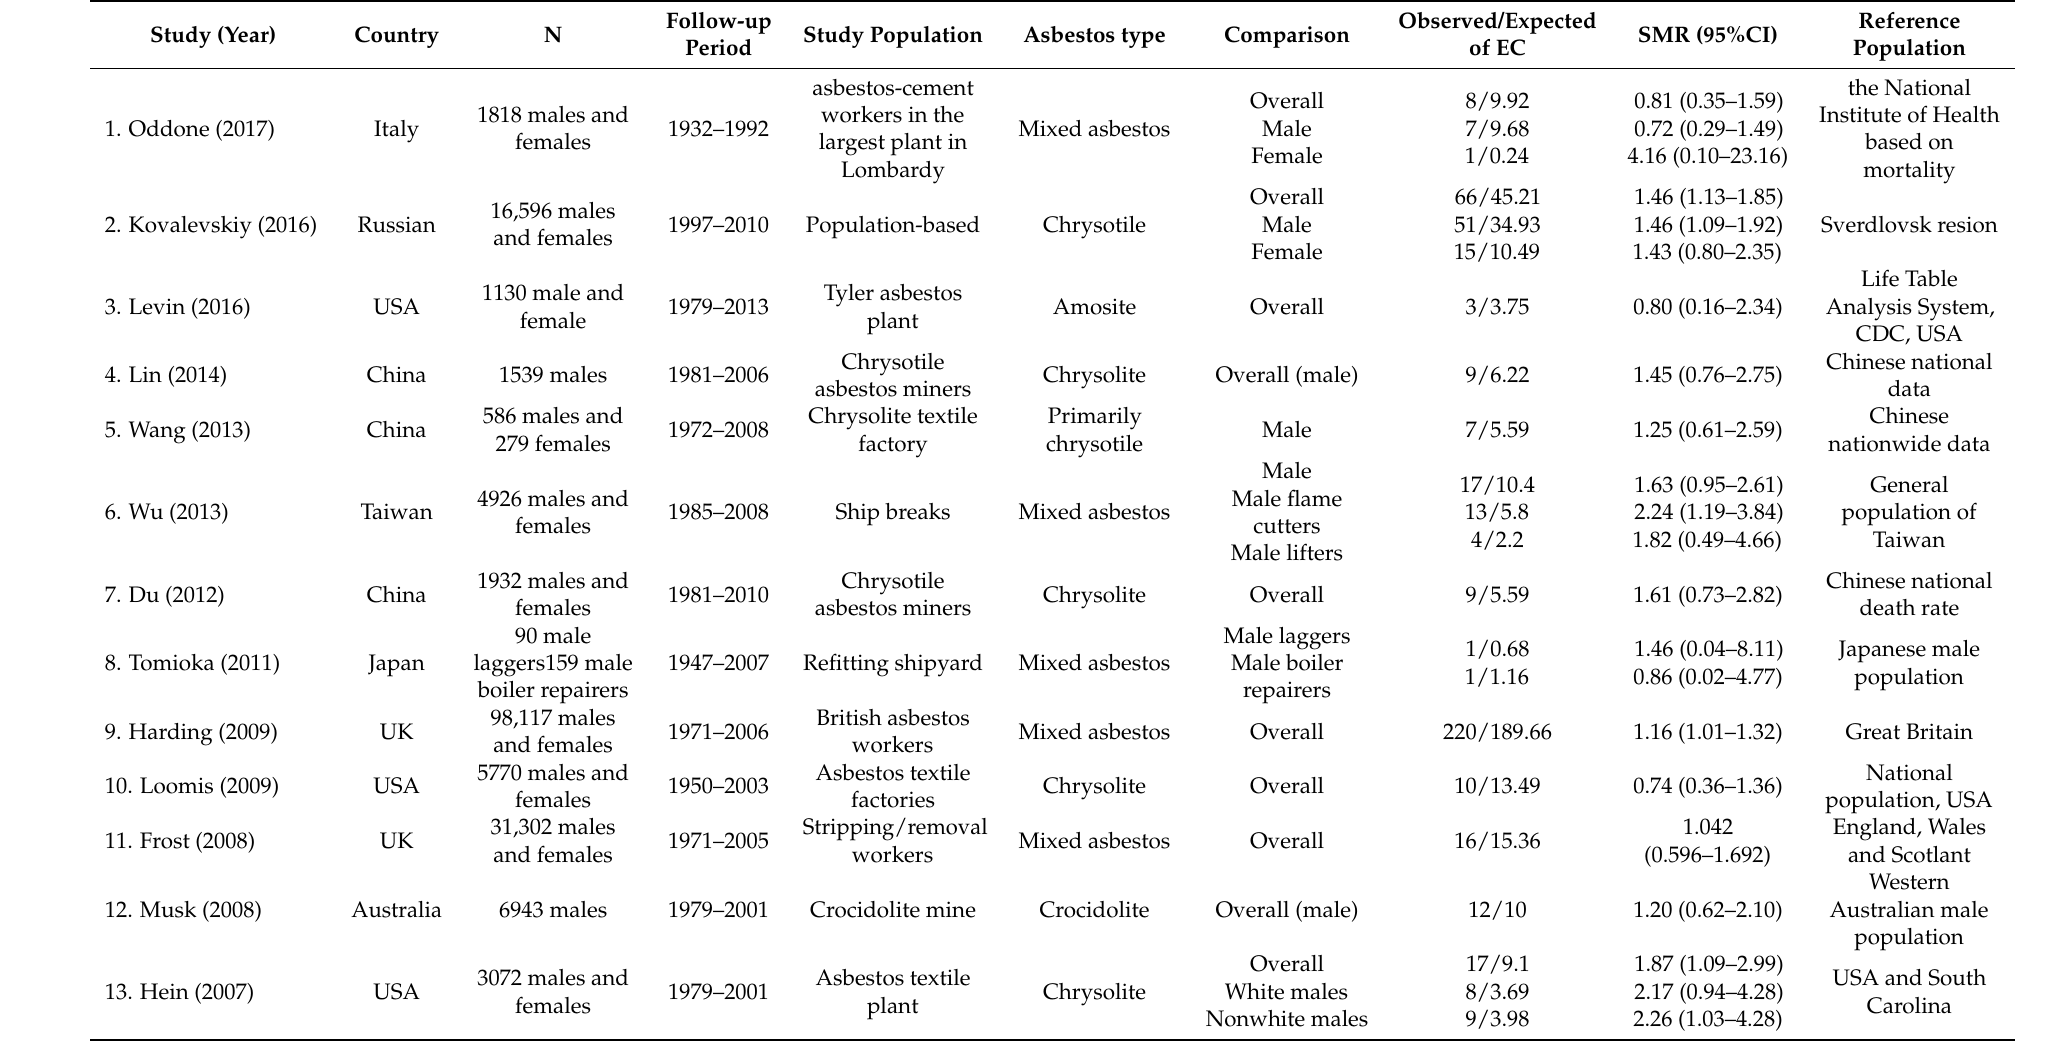
Table 1. Studies included in the meta-analysis study (N =